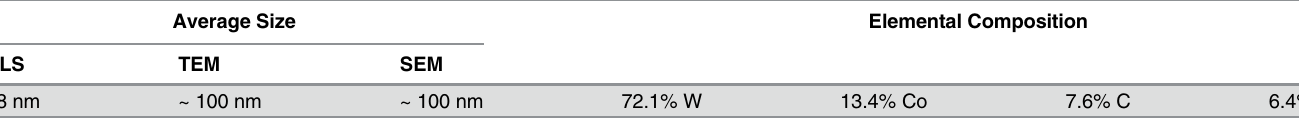
Table 1. Summary of the characteristics of WC-Co NP, including size and elemental composition. Average